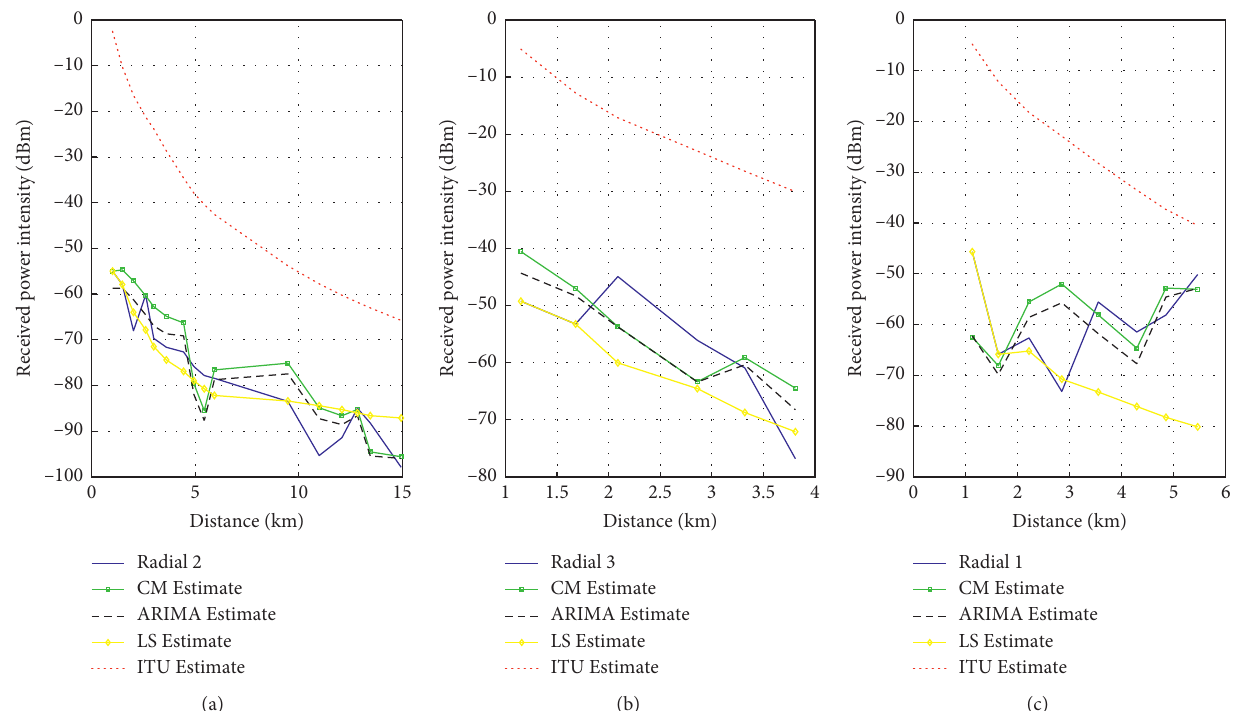
Figure 5: Graphs of the combined ARIMA model adjust for radial 2 (a) and estimates for radial 3 (b) and 1 (c).